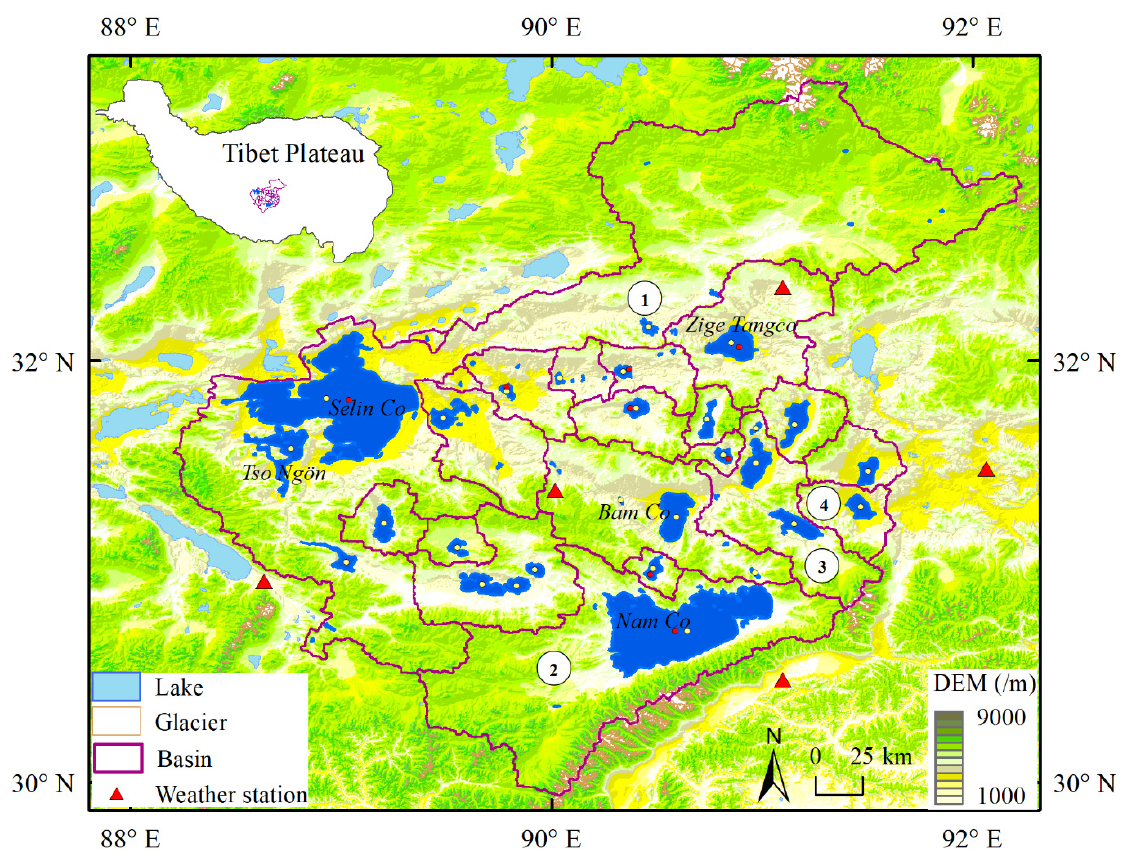
Figure 1. Spatial distribution of the studied lakes, watersheds, and meteorological stations on the southeastern TP. Red points on the lake indicate that CryoSat data are available for the lake and yellow points indicate that ICESat data are available. The Arabic numbers in black circles indicate the glacier-fed basins. Table 1. Characteristics of the 28 lakes with altimetry data on the southeastern TP.